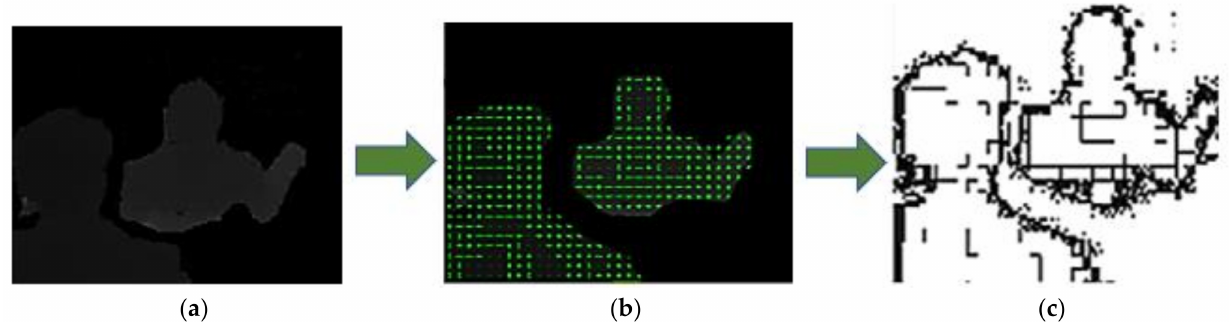
Figure 5. Results of fused joint HOG-LBP over the PCDS dataset where ( a ) shows the original depth image, ( b ) shows the HOG results and ( c ) shows the LBP results.